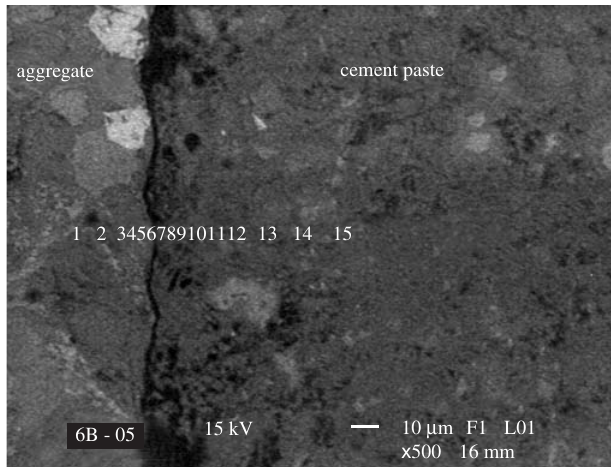
Figure 1. SEM-BSE images of ITZ perpendicular lines.